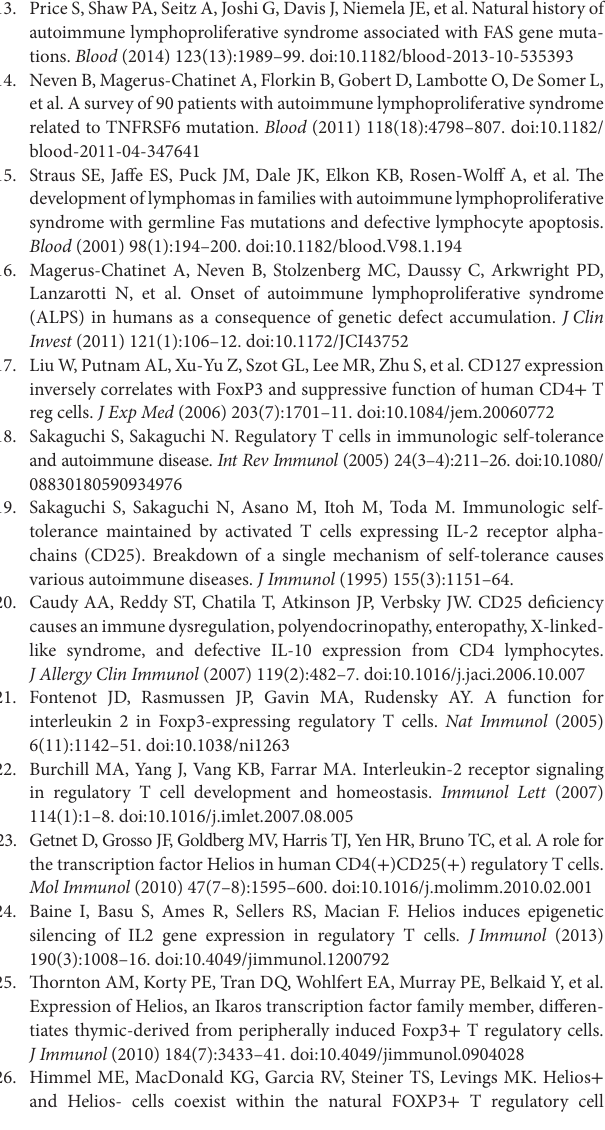
FigUre s1 | Phenotypic characteristics of regulatory T cells (Tregs) in autoimmune lymphoproliferative syndrome (ALPS) patients. CD3 + CD4 + -gated T lymphocytes isolated from three healthy controls (CTs) (CT) or three ALPS patients (ALPS: P7, P8, and P15) were stained for CD25 and CD127 (a) . Next, CD4 + CD127 − CD25 + -gated T cell subpopulations were stained for CTLA4. In parallel, for two of these patients (ALPS: P7 and P15), CD3 + CD4 + - gated T lymphocytes isolated were also stained for CD15s and CD127. Next, CD4 + CD127 − CD15s + -gated T cell subpopulations were stained for CTLA-4 (b) . The CD4 + CD127 − CD15s + -gated T cell subpopulations of three other patients were also stained for CCR7, GITR, ICOS, CD39, LAG3, CD59, PD1, CD27, and CD28 (c) . The mean intensity of fluorescence was added for the control and the ALPS patients. Histograms are normalized to mode for panel (c) . FigUre s2 | Different proportion of antigen-presenting cell (APC). The mean proportion of total CD11c + CD4 low APCs (left panel) and the mean ± SD (range) proportion of CD11c + CD4 low CD14 + monocytes [82.9 ± 4% (75–89%); n = 10; middle panel] and CD11c + CD4 low CD14 − DCs [15.8 ± 5% (9–24%); n = 11; right panel] among PBMCs from CTs